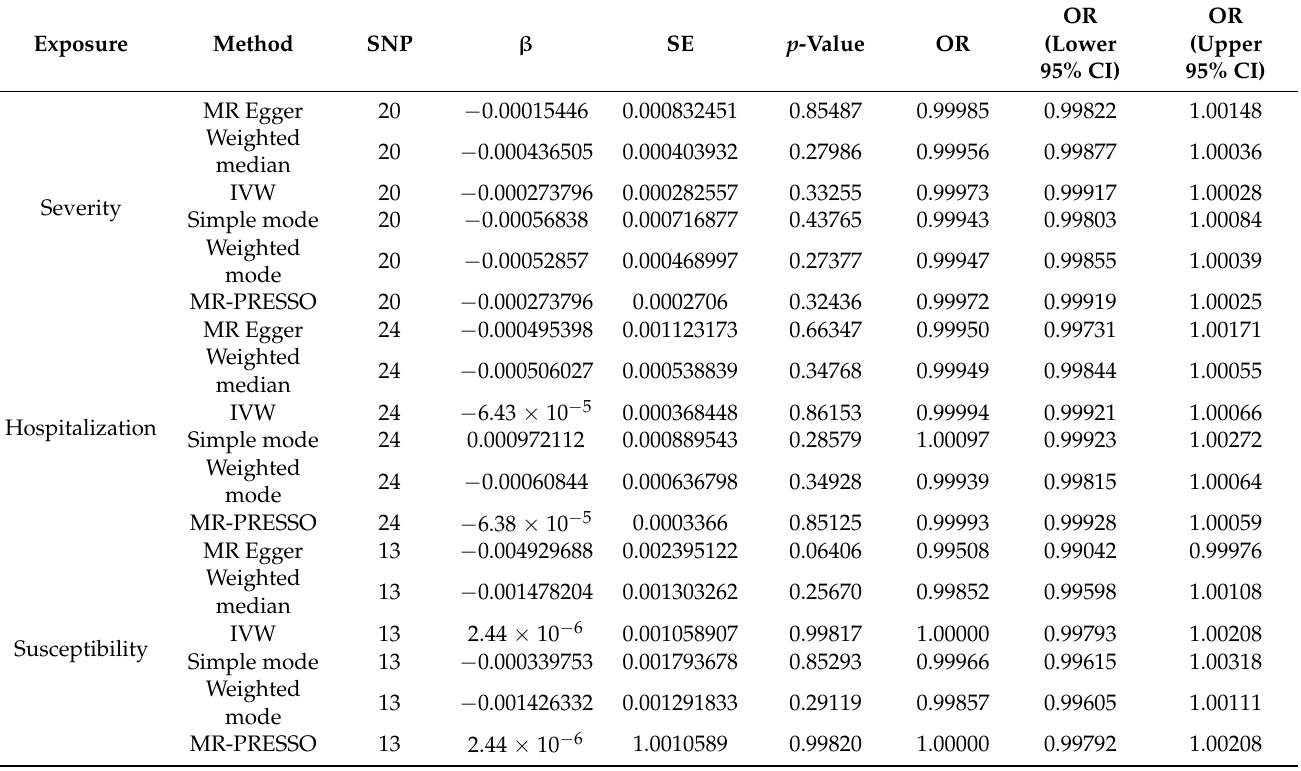
Table 2. TSMR Results.